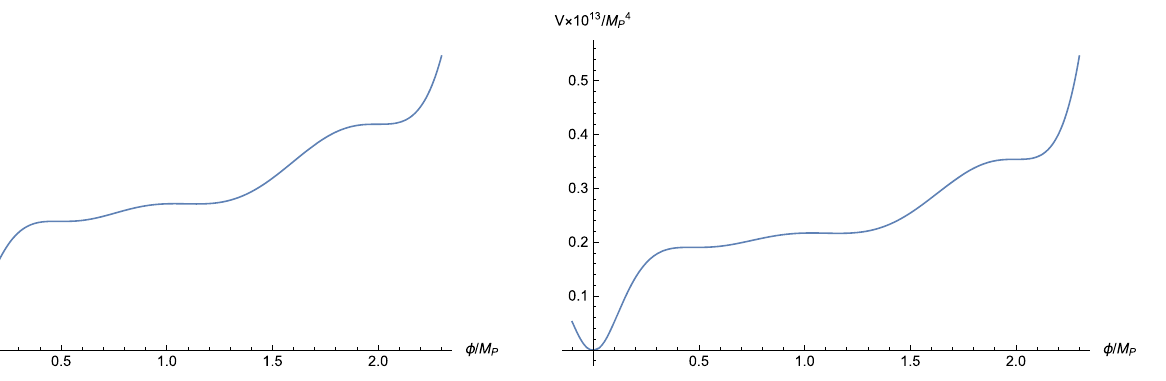
Fig. 1 Scalar potential V (φ) of Model I for the parameter set (20) Fig. 2 Scalar potential V (φ) of Model II for the parameter set